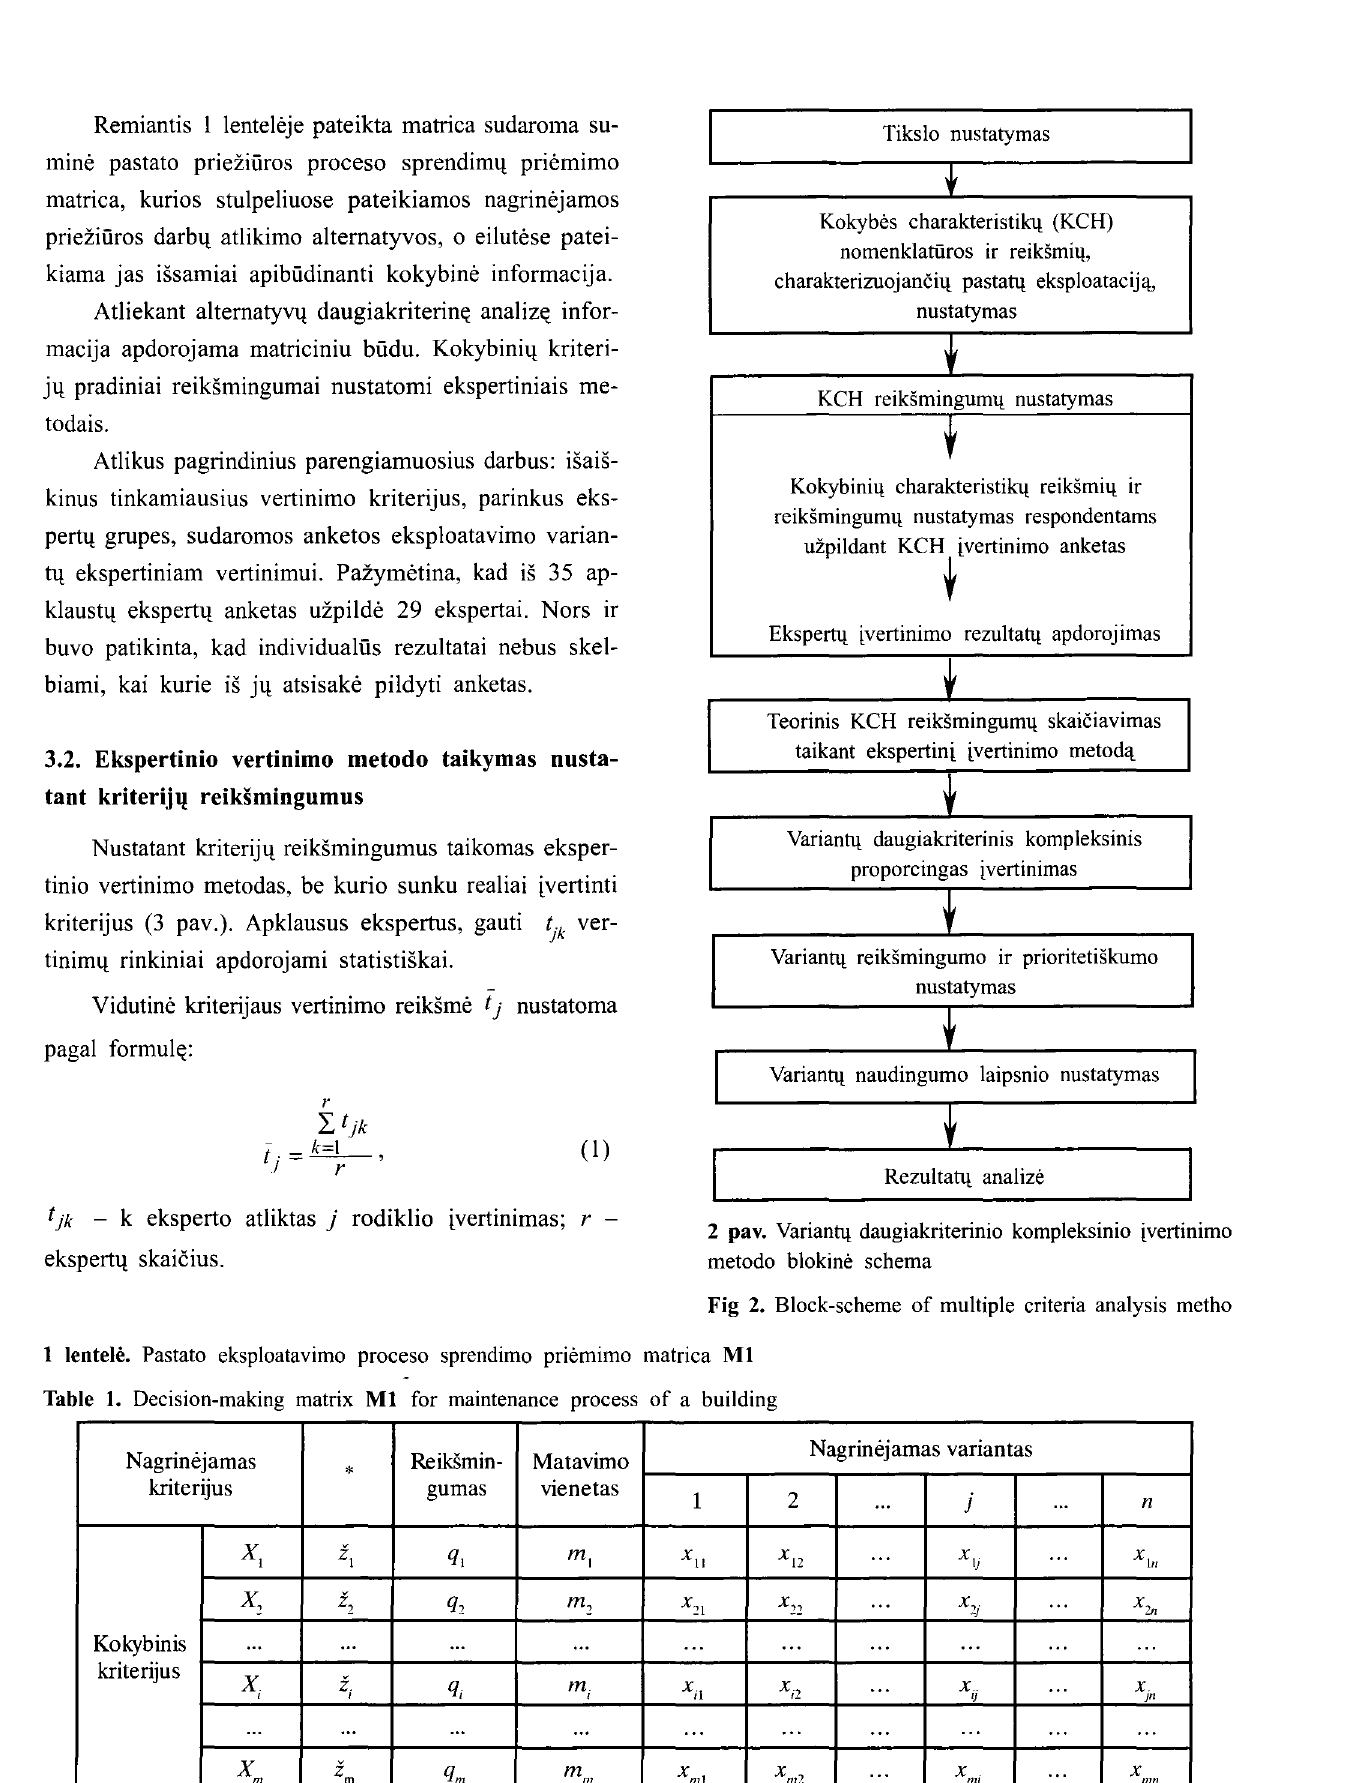
Table 1. Decision-making matrix M1 for maintenance process of a building